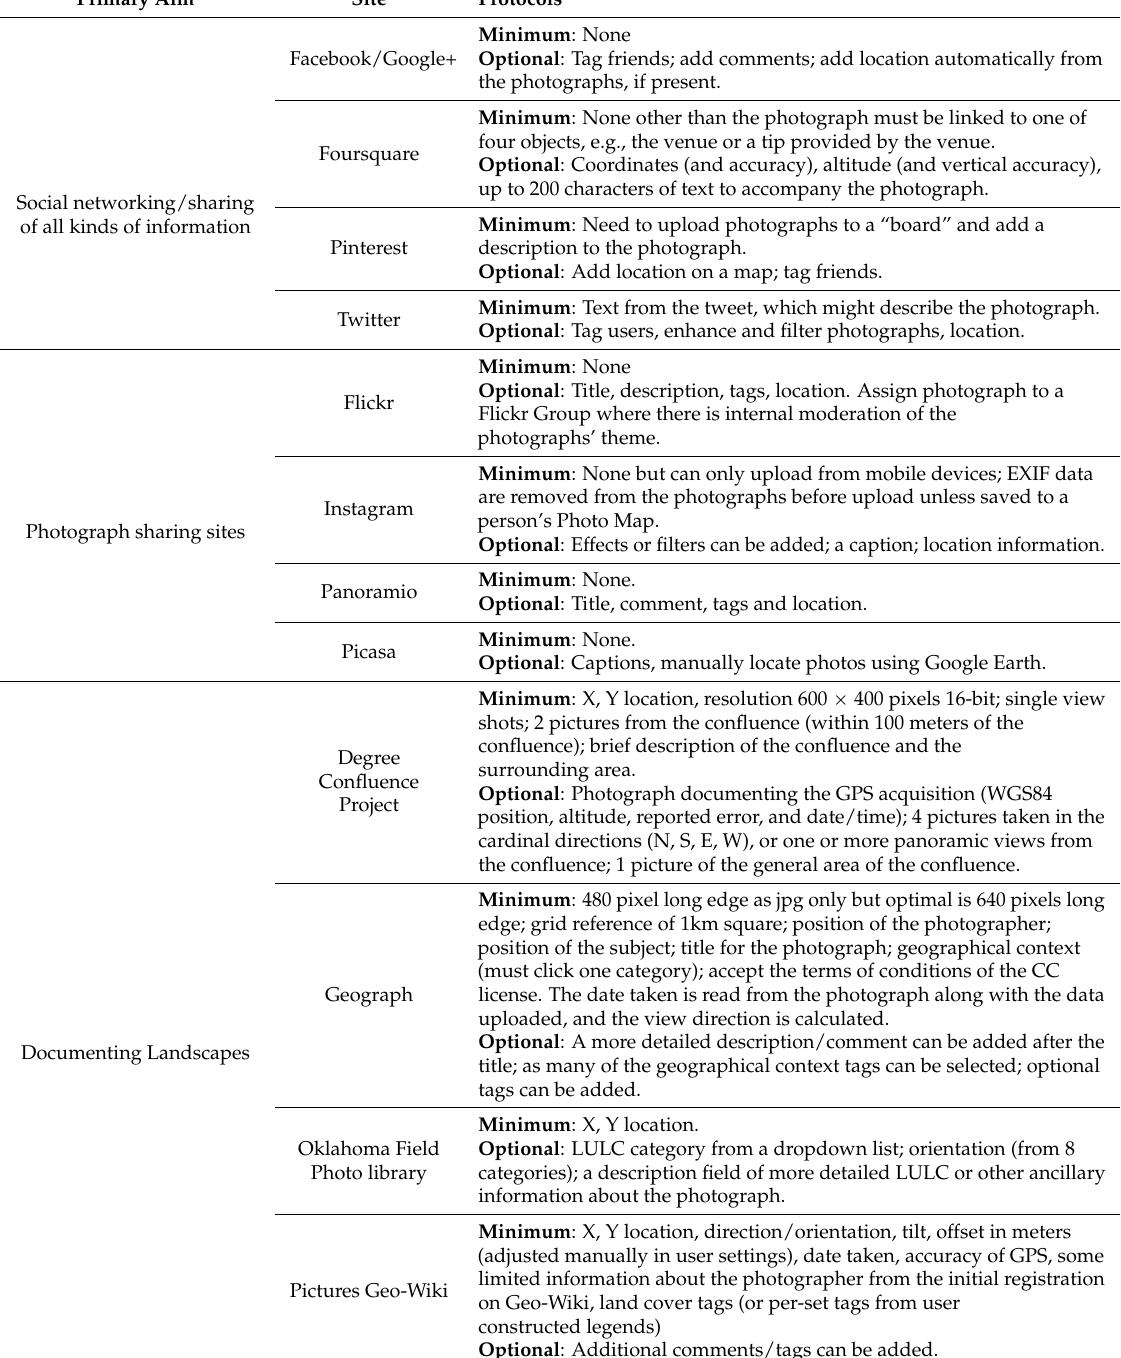
Table 1. Protocols associated with different sites where photographs are